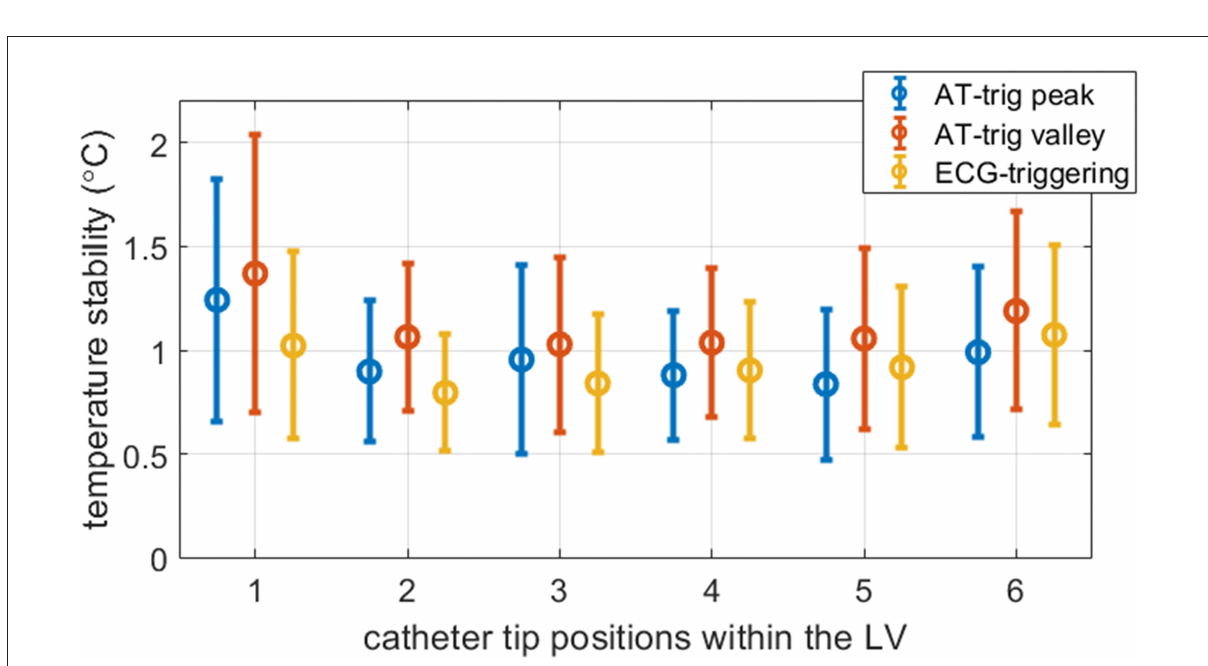
FIGURE8 Measured temperature stability in all experiments. Per triggering method, the mean and standard deviation were calculated for all voxels inside myocardial masks combined over the three slices. The 2 AT-trig strategies (AT peak and AT valley) resulted in similar temporal stability compared to ECG-triggered sequences. The precision of scans triggered on the peak of the AT signal matched more closely to ECG-triggered data than scans triggered on the valley of the AT signal. In the first LV position visited in these experiments, the mean and spread in temperature stability measured with both AT strategies were higher than in the other LV positions